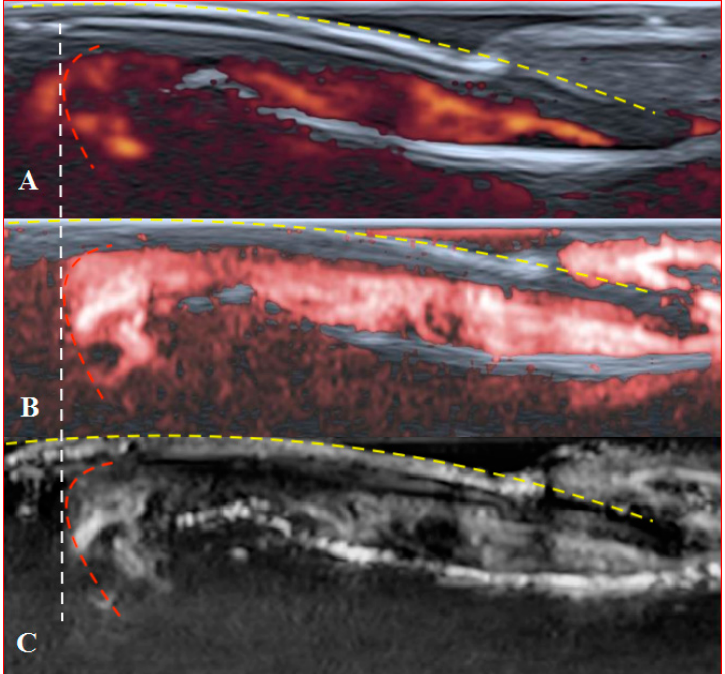
Figure 6. Sagittal scans of a healthy fingertip with high gain: ( A ) PD; ( B ) cSMI; ( C ) mSMI. The true flow is the highest signal that dissociates from the random noise dots clearly. It is hard to say how much blooming artefact is involved. The transverse dotted line through all images separates the area under the nail close to the fingertip (red dotted line); a gel manicure does not change the quality of the image but longer nails provoke flash artefacts.